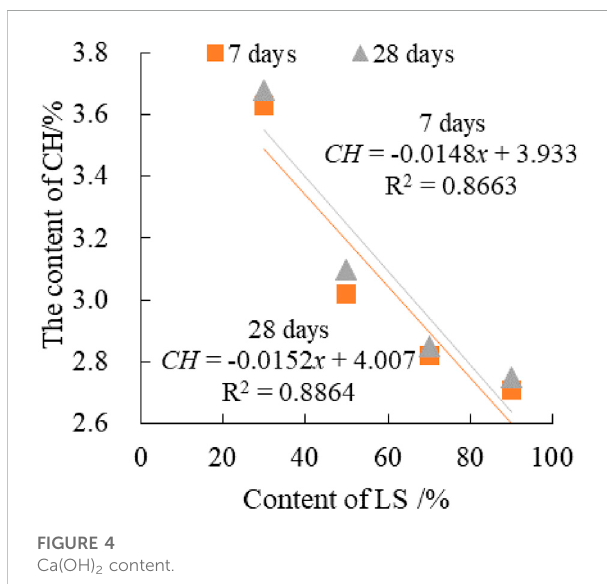
FIGURE 4 Ca(OH) 2